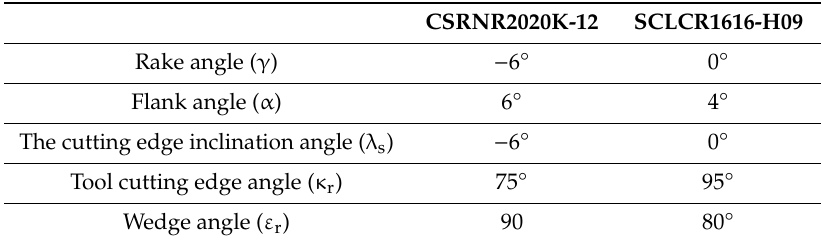
Figure 3. CSRNR2020K-12 ( a ) and SCLCR1616-H09 ( b ). Table 1. The geometry of used